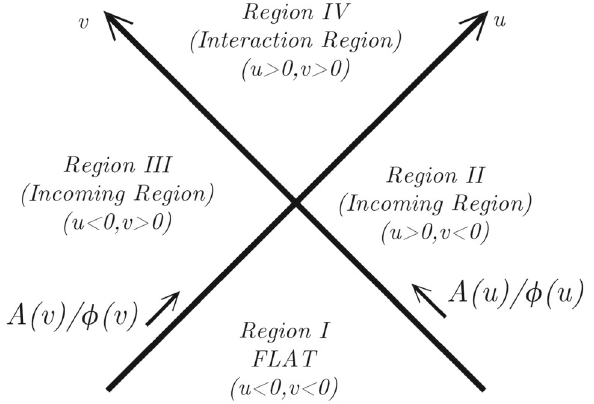
Fig. 1 The u − v picture for colliding waves in 2+1-dimensions. The third dimension x - is orthogonal to the plane so that each point in the plane represents a